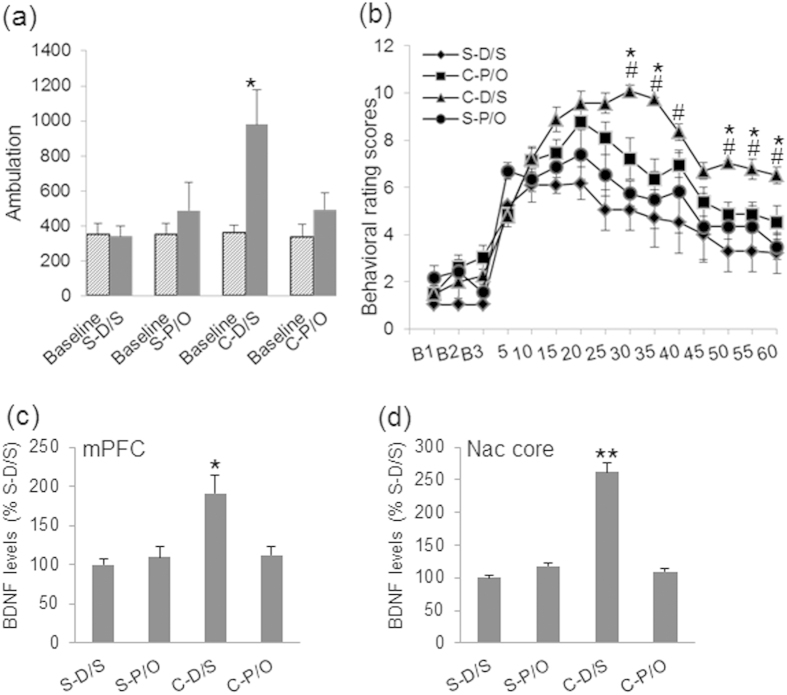
Pergolide/ondansetron (P/O) treatment blocked cocaine-induced behavioral sensitization and BDNF protein expression.Animals were treated as described in Materials and Methods. The cocaine sensitized rats (C-D/S) showed behavioral sensitization in ambulation (a) and behavioral rating scores (b) relative to the C-P/O and the saline controls (S-D/S and S-P/O). *p < 0.01, C-D/S versus all groups; #p < 0.05, C-D/S vs C-P/O. (c) BDNF levels in the mPFC were enhanced in the C-D/S group relative to all others. (d) BDNF levels in the NAc core were increased in the C-D/S group relative to the C-P/O and the two control (S-D/S and S-P/O) groups. See Figure 1 for details of the groups. *p < 0.05, **p < 0.01, C-D/S versus all groups. S-D/S, saline-DMSO/saline; S-P/O, saline-pergolide/ondansetron; C-D/S, cocaine-DMSO/saline; C-P/O, cocaine-pergolide/ondansetron.